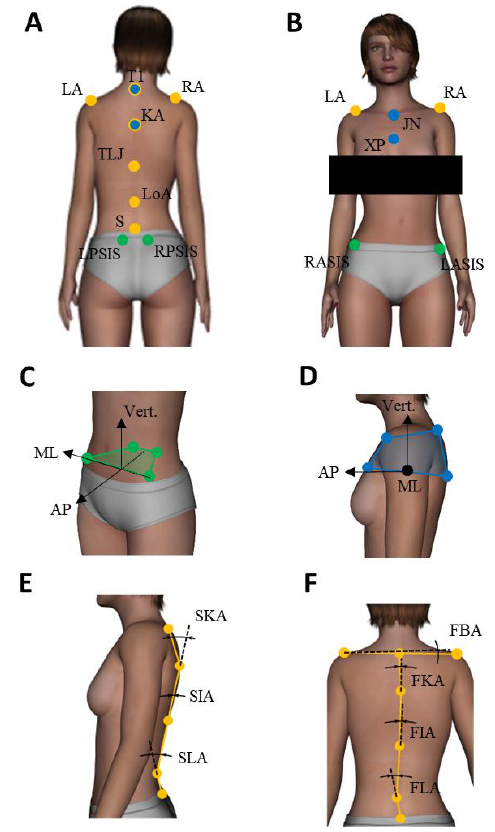
Figure 1. Reflective marker positions and dependent variables definition. Back ( A ) and front ( B ) views of markers location. The reference frame was defined by its antero-posterior axis (AP), the horizontal symmetry axis between both feet, its medio-lateral axis (ML) perpendicular to the AP axis in the horizontal plane, and its vertical axis, normal to the horizontal plane pointing upwards. ( C ) Definition of a pelvic rigid body (green markers): ML axis is defined as the axis connecting RASIS and LASIS, the vertical axis is normal to the plane containing RASIS, LASIS, and the middle of RPSIS and LPSIS then the AP axis is the vector product between ML and vertical axis. ( D ) Definition of a thoracic rigid body (blue markers): vertical axis is defined as the axis connecting the middle of XP and KP and the middle of T1 and JN, the ML axis is normal to the plane containing T1, JN, and the middle between XP and KM, then AP axis is the vector product between ML and the vertical axis. ( E ) Definition of the sagittal angles of the spine (yellow markers). ( F ) Definition of the frontal angles of the spine and of the biacromial line, connecting LA and RA (yellow markers). Note that the transverse rotation of the biacromial line and the global angle of the spine with respect to the vertical in sagittal and transverse planes, which have also been investigated are not represented here.